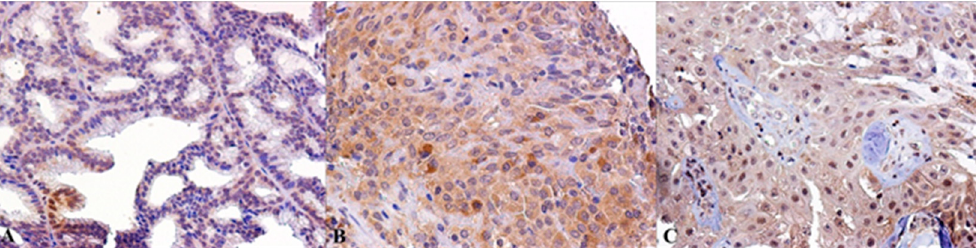
Figure 5. Nuclear GPR30 IHC staining of SGTs samples: ( A ) ACC; ( B ) Myoepithelioma; ( C ) MEC (Magnification 20×).